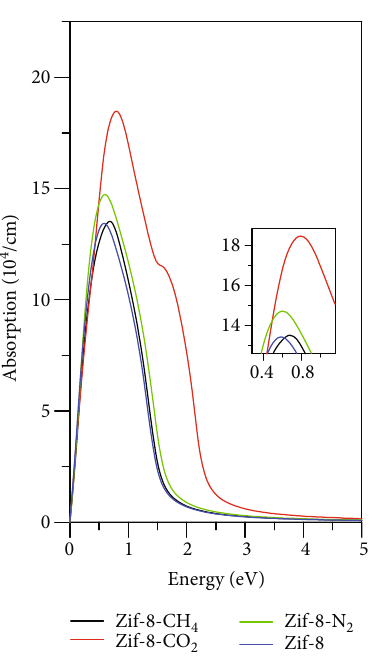
Figure 7: The adsorption coe ffi cient of Zif-8 and M +Zif-8 compounds.